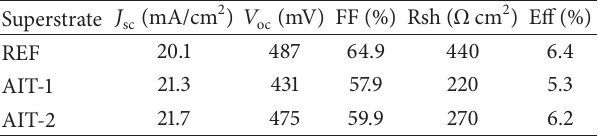
Figure 5: Spectrally resolved haze for the three investigated super- strates. Table 2: One-sun 𝐼 - 𝑉 parameters of the best 𝜇 c-Si:H solar cells processed on the three investigated